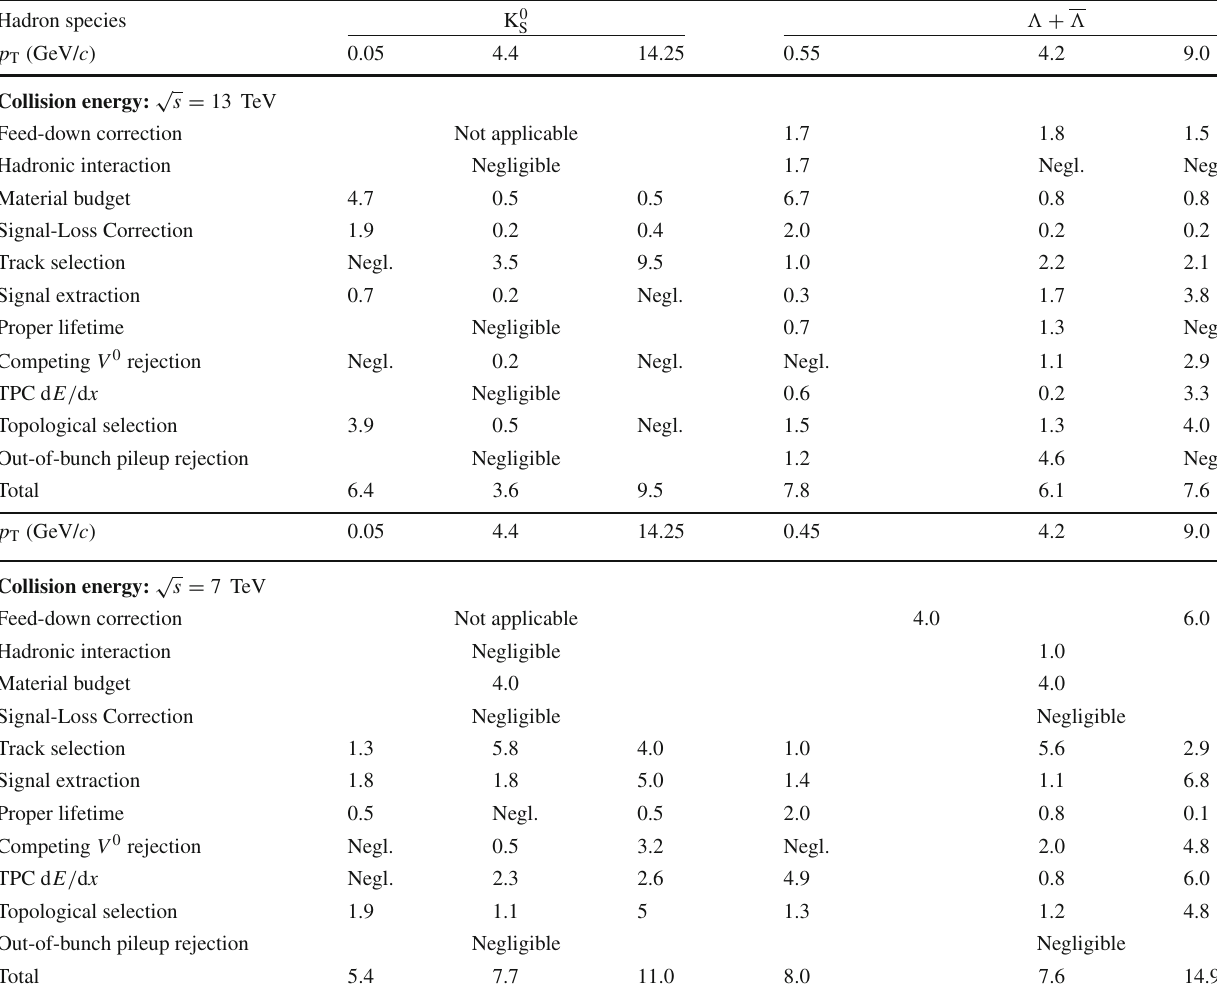
Table5 Summaryofthemainsourcesandvaluesoftherelativesystem- atic uncertainties (expressed in %) for the K 0 yields.Asinglevaluebetweentwoorthreecolumnsindicatesthatno p T Hadron species K 0